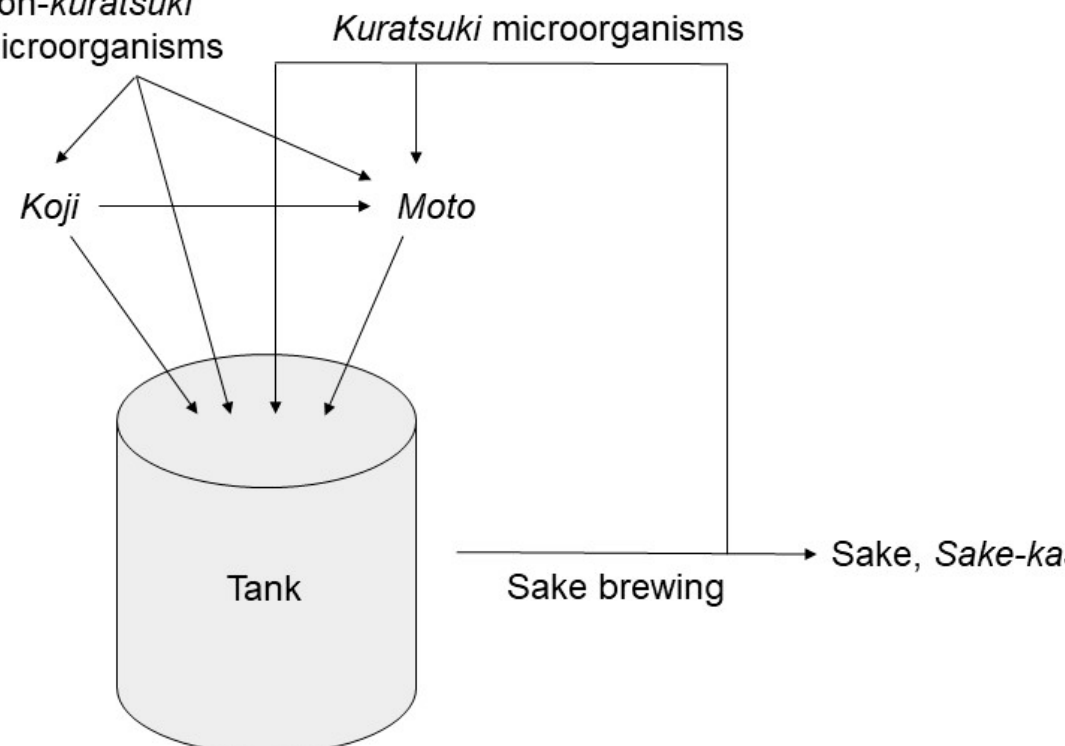
Figure 4. Difference between kuratsuki and non- kuratsuki microorganisms in the sake brewing process. Koji contains Aspergillus oryzae . Moto contains A. oryzae and Saccharomyces cerevisiae . S. cerevisiae in moto produces ethanol during the sake brewing process.